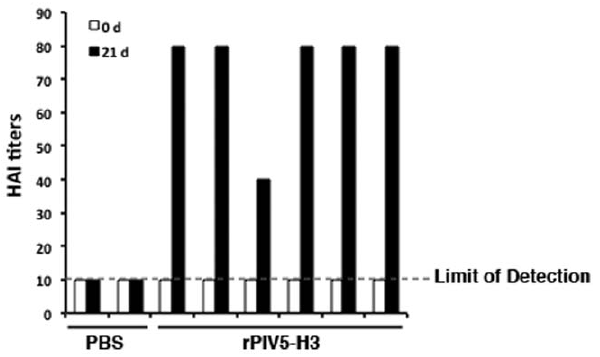
Figure 6. Immune responses in the PIV5-vaccinated dogs inoculated with rPIV5-H3. The dog blood samples were collected at 0 and 21 dpi. Anti-PIV5 and HAI titers were determined using the same approach as in Fig.